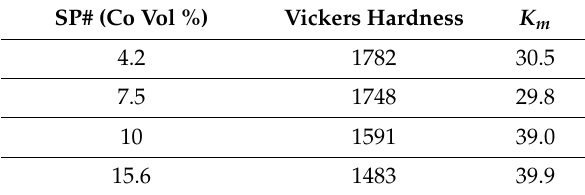
Table 2. Data from Seikh et al. [9] on Co Vol %; Vickers hardness and